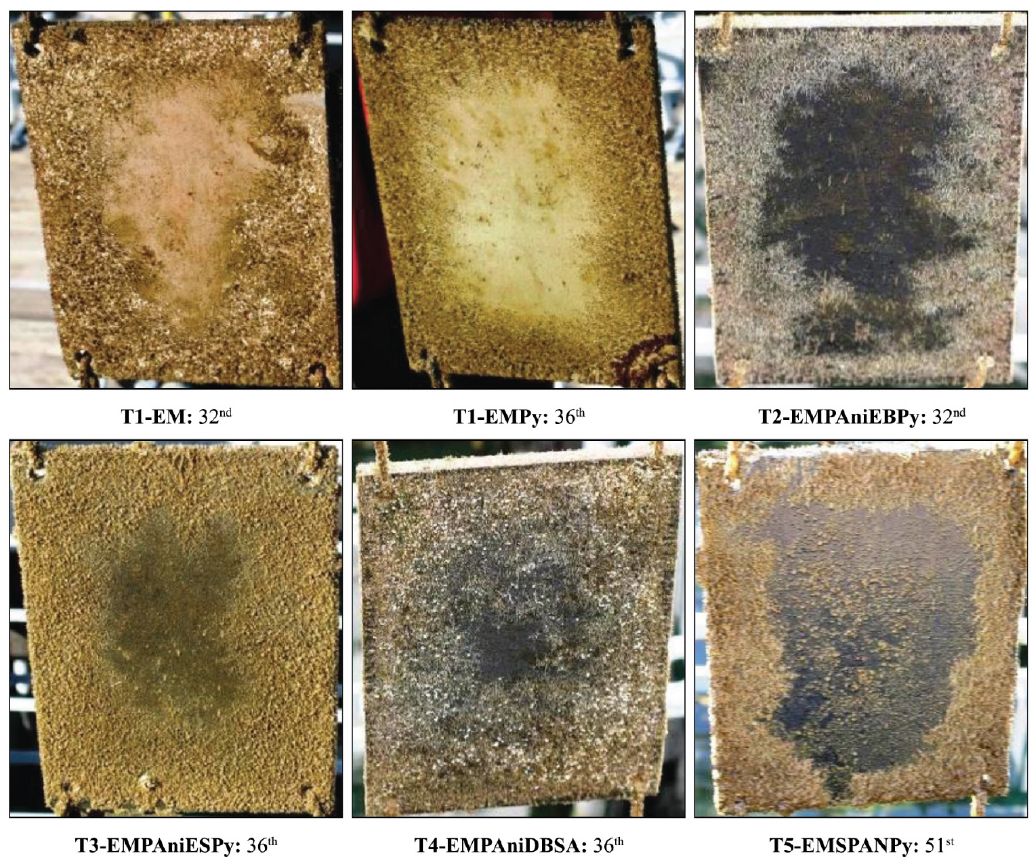
Figure 6. Appearance of coated steel plates and their time of immersion in the marine environment (Toulon -